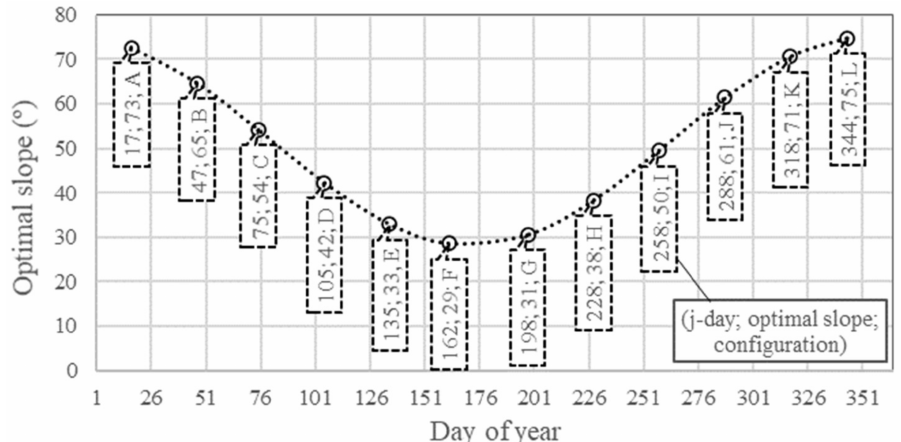
Figure 2. Optimal slope of PV panels for each monthly characteristic j-day. Location: Lodz, Poland (Latitude: 51.75 ◦ ; Longitude: 19.45 ◦ , a.a.s.l.: 278 m). Optimal angles were determined by using